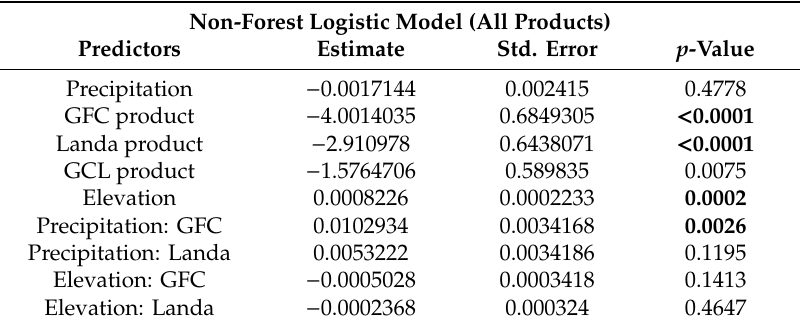
Figure A4. GFC estimated tree cover across Costa Rica, displayed to emphasize bias patterns. Note differences in estimated tree cover between the east and west of the country; similar trends do not exist in the reference tree cover data, as noted in Figure 4A. Table A3. Detailed model fit for the non-forest multiple logistic regression of the probability of predicted forest cover (0 or 1) against precipitation, elevation, and product type (GFC, Landa, and GCL). The data used for this analysis were non-forest reference data where tree cover was <10%.